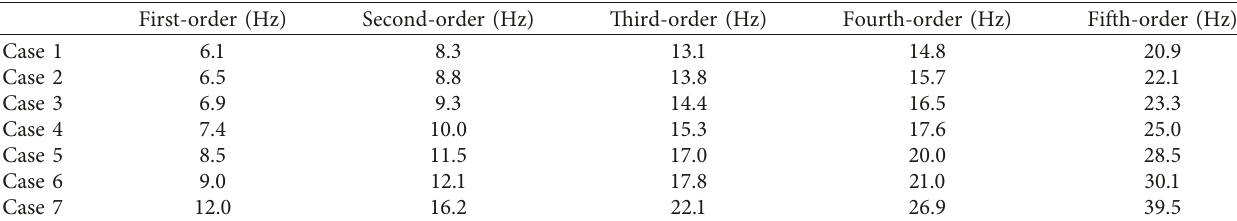
Figure 7: Time-domain waveform and spectrum of plane wave: (a) time-domain waveform under excitation; (b) spectrum. Table 1: Structural natural frequencies of seven